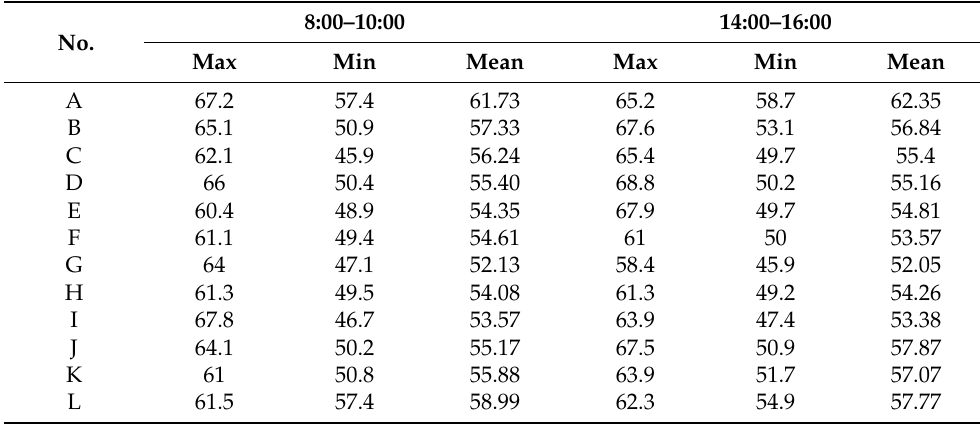
Table 3. Sound pressure level research measurement point data description